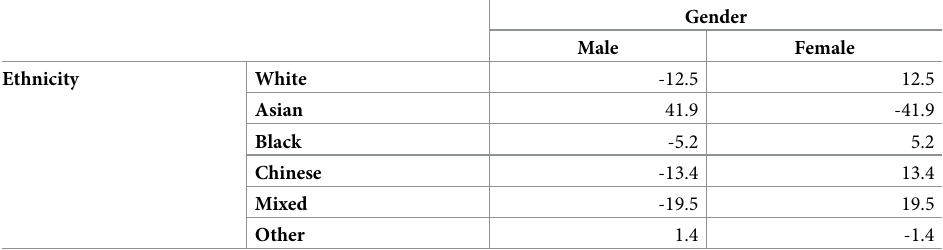
Table 7. Chi 2 test of independence adjusted residuals for ethnicity and gender (analysed using dataset 2 –April 2015).